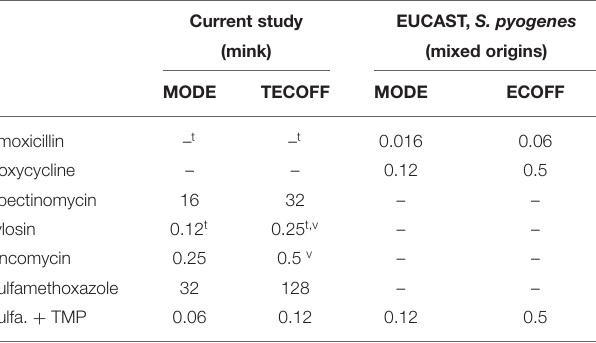
TABLE 4 | Streptococcus canis isolated from mink—tentative ECOFFs and modes of MIC wildtype distribution, compared with modes and ECOFFs for S. pyogenes from EUCAST.